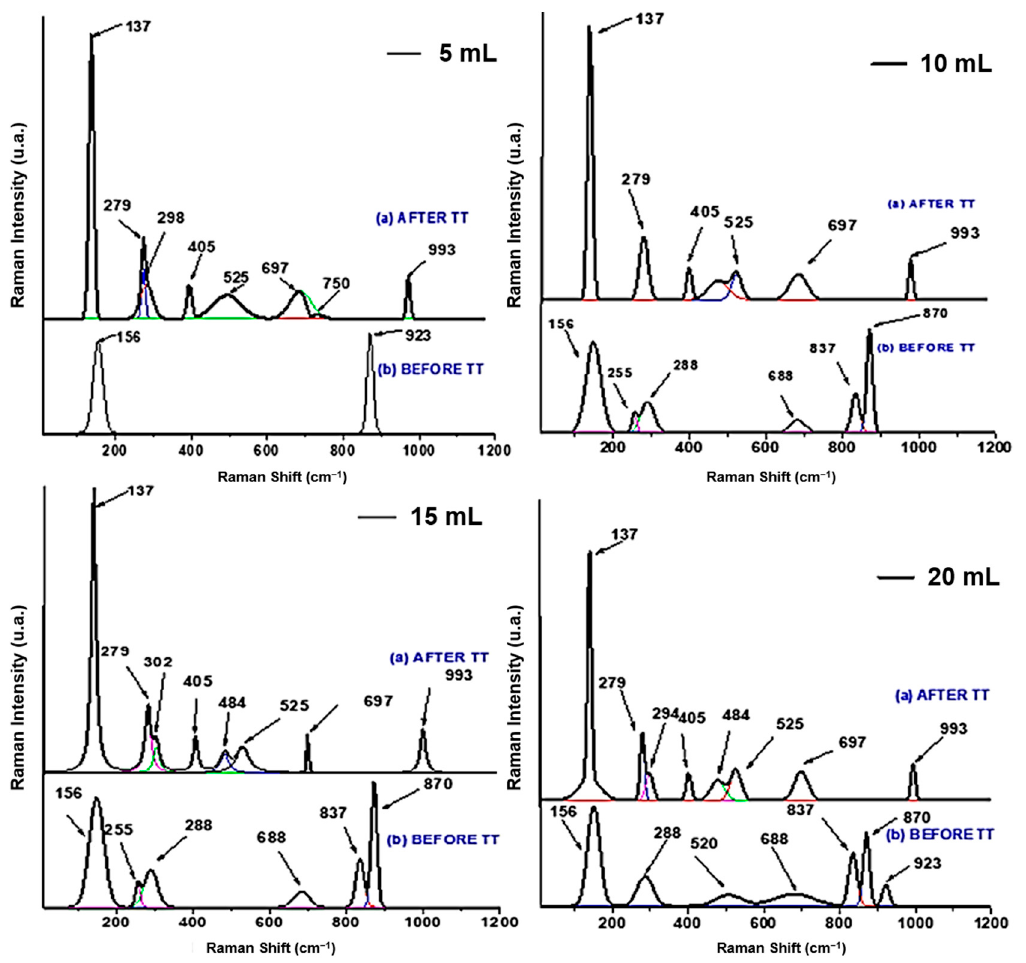
Figure5. Ramanspectraof0.01Mand5, 10, 15, and20mLsamples, Figure 5. Raman spectra of 0.01 M and 5, 10, 15, and 20 mL samples, before annealing and after annealing.